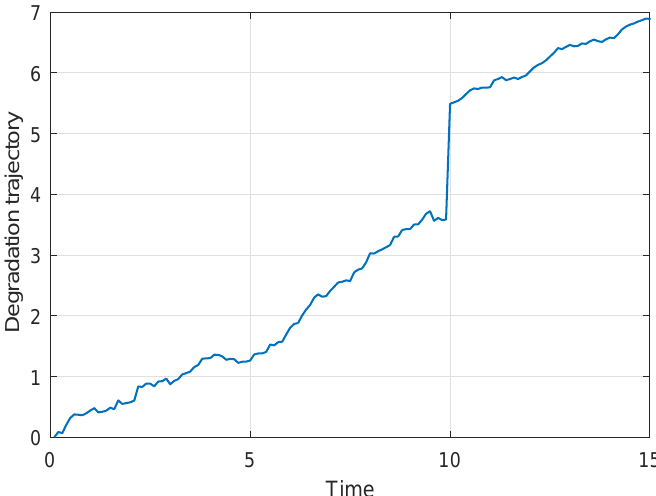
Figure 4. The single degradation process for illustration.